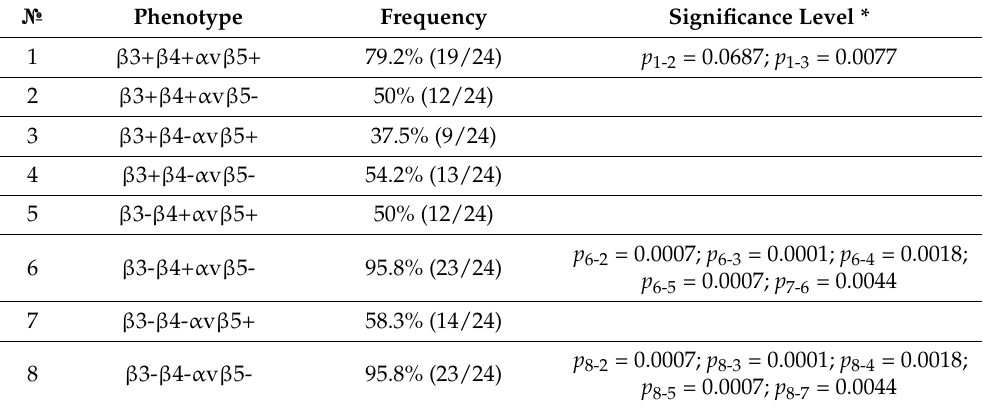
Figure 1. ( A ) A representative image of microvesicles isolated from the plasma of a breast cancer patient: ovals show exosomes, white arrows show protein aggregates, black arrows show non-vesicles (40–80 nm). The inset in the right angle shows a non-vesicle (20–40 nm) and 2, 3 represent exosomes, while 4 represents large vesicles (100–200 nm). ( B ) Intrapersonal variants of exosomal integrins co-expression in each breast cancer patient. ( C ) Proportions of exosomes co-expressed β3, β4, and αVβ5 integrins in breast cancer patients with metastasis in different organs. Samples were tested for statistical outliers, then one-way ANOVA was used to compare the means of independent groups. Table 2. Frequency of occurrence of β 3, β 4, and α V β 5 integrins co-expression on exosomes of breast cancer